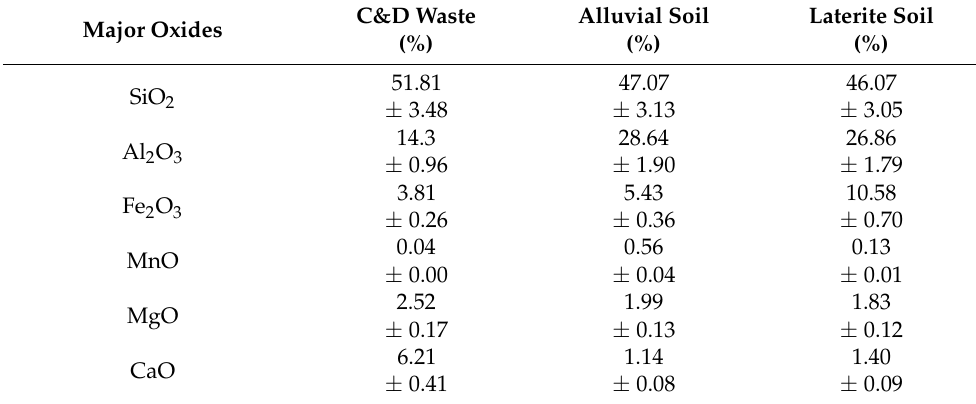
Table 2. Chemical composition of raw